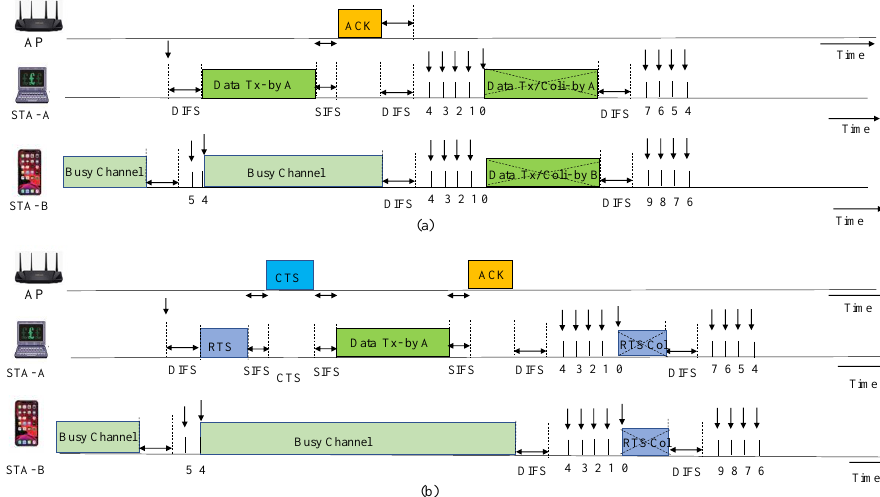
Figure 2. Successful and collided transmissions in the IEEE 802.11 ( a ) DCF Basic and ( b ) DCF RTS/CTS Channel-Access